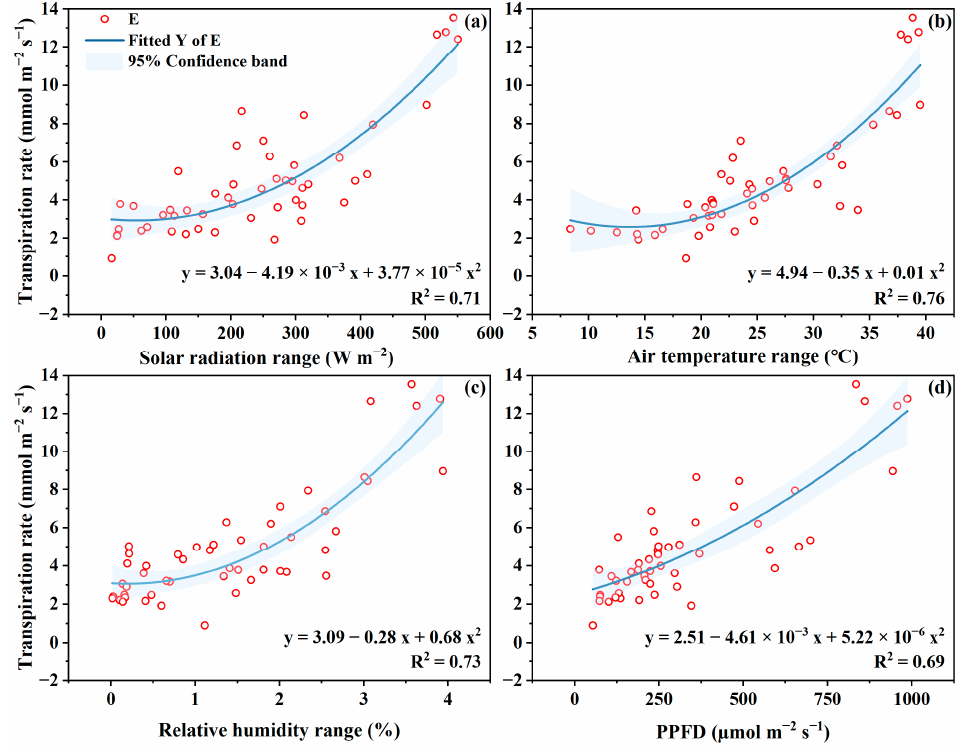
Figure 5. The relationships between leaf transpiration rate to solar radiation ( a ), air temperature ( b ), vapor pressure deficit ( c ) and the photosynthetic photon flux density (PPFD) reaching to leaf ( d ).